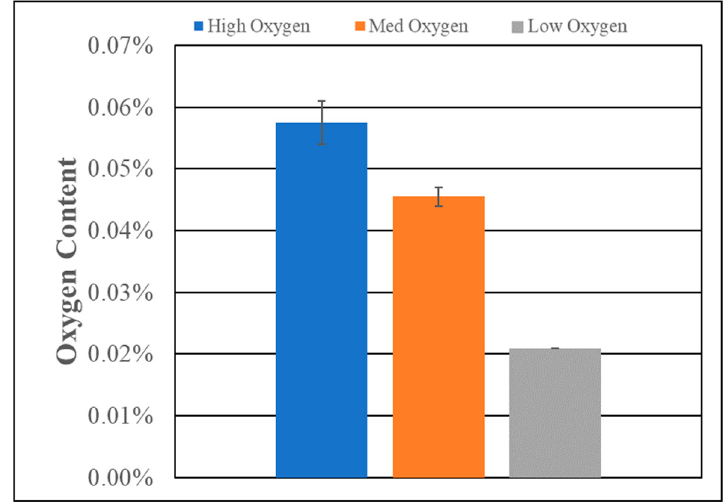
Figure 5. Oxygen content of evaluated aluminum powders.